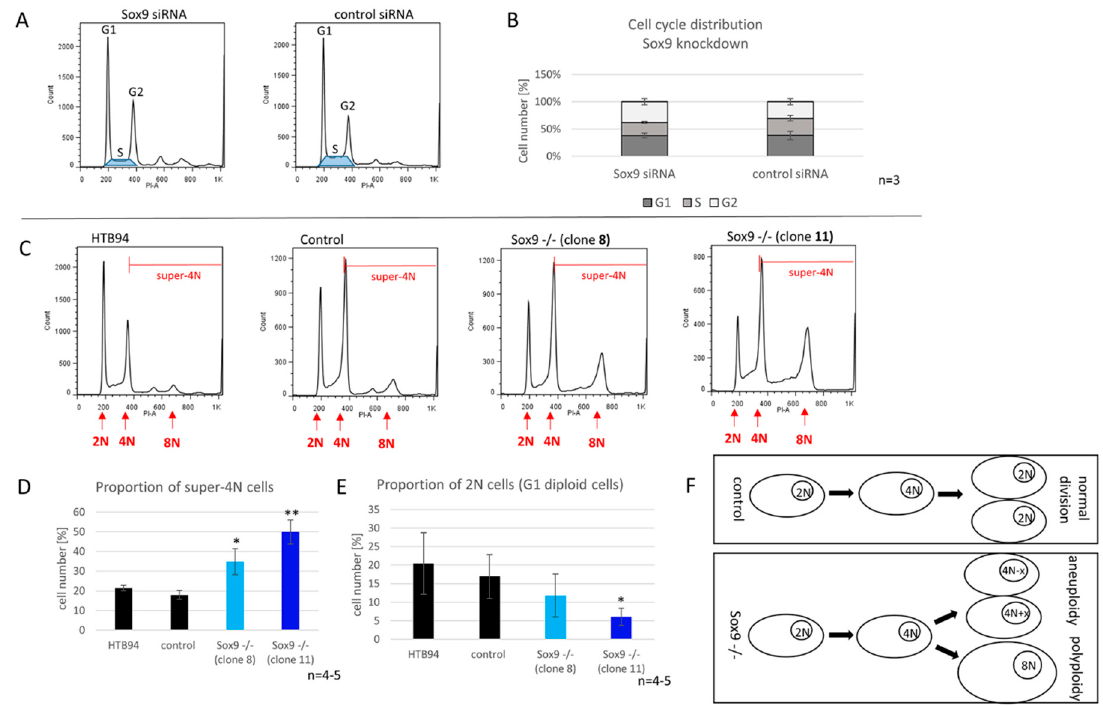
Figure 5. Cell cycle distribution of SOX9 knockdown and knockout cells. ( A ) Representative flowcytometric cell cycle analysis of SOX9 knockdown cells and the distribution of cell cycles phases after SOX9 knockdown ( B ). ( C ) Representative flowcytometric cell cycle analysis of SOX9 knockout clones. The area of super-4N cells (4N = DNA content after replication and before mitosis) is marked with red lines. ( D ) The proportion of super-4N cells is significantly increased in SOX9 knockout clones 8 and 11 compared to control. ( E ) The number of cells in G1-phase was reduced by trend in SOX9 knockout clone 8 and reduced significantly in the SOX9 knockout clone 11 compared to the control. ( F ) The development of aneuploidy or polyploidy after the SOX9 knockout. Control cells do not (or to a much smaller extent) exhibit genetic instability and maintain a diploid genome after division, whereas Sox9 − / − cells reveal abnormalities during division leading to aneuploid and / or polyploid cells. Results are the means ± SD; * p ≤ 0.05; ** p ≤ 0.01.